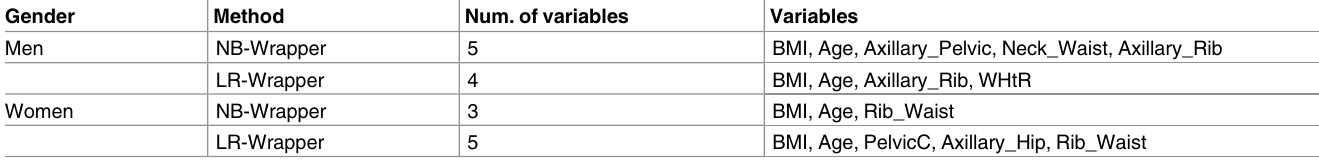
NB-Wrapper: na ï ve Bayes with wrapper-based variable subset selection technique, LR-Wrapper: logistic regression with wrapper-based variable subset selection